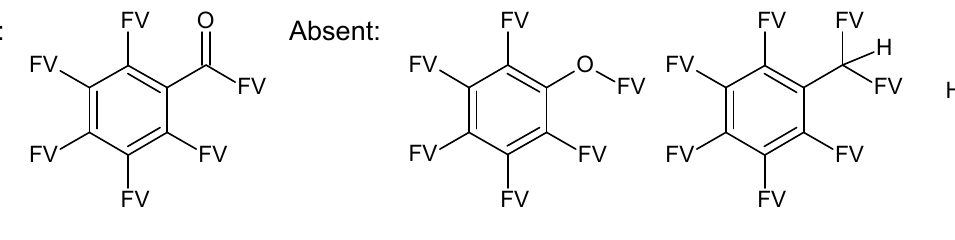
Figure A9. Substructures for GC–MS Challenge 10. FV = free valence.